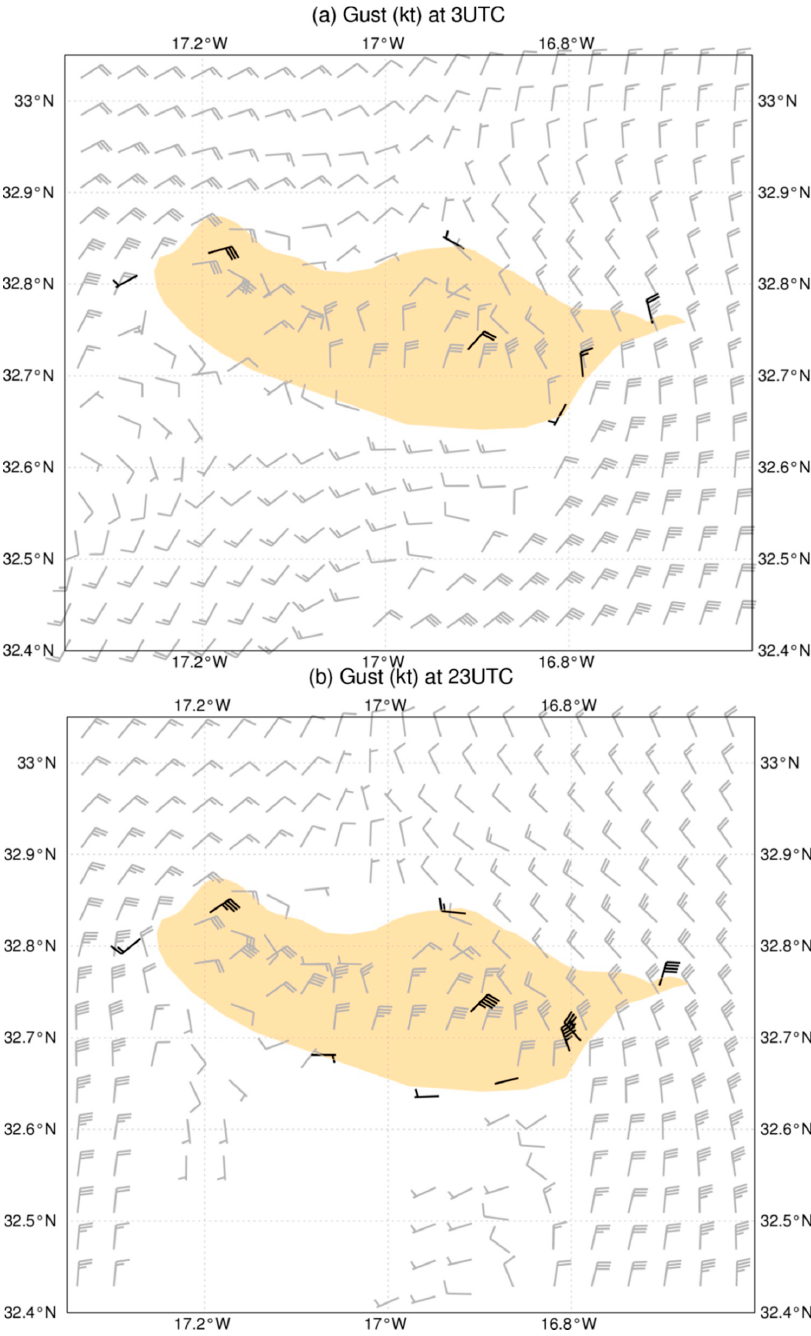
Figure 10. Observed (black barbs) and AROME forecast (grey barbs) of the wind gusts at 03 UTC ( a ) and 23 UTC ( b ) on 7 August 2016. In the area of the airport are represented only the barbs of the observations at RS site and RWY05.